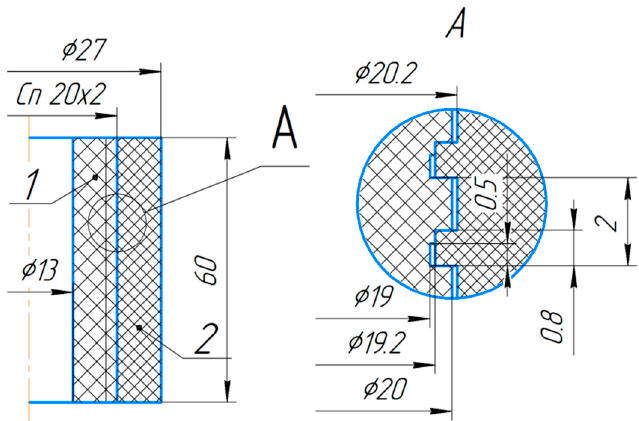
Figure 3. Threaded connection with special thread.